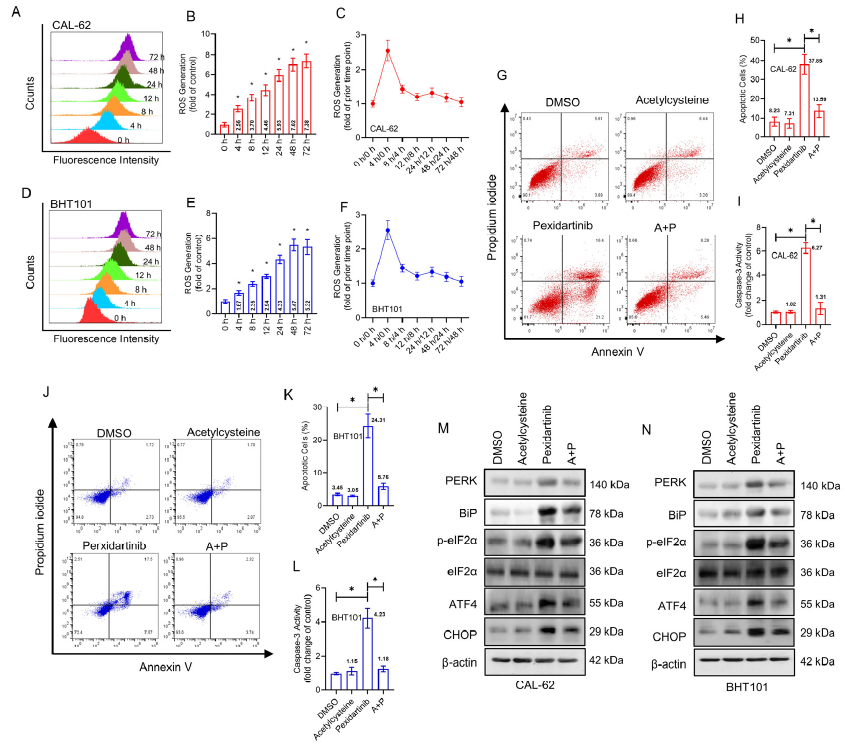
Figure 4. Pexidartinib induces ROS elevation in ATC cells. ( A , B ) ROS levels determined after treatment with pexidartinib at IC 50 concentration for various time points in CAL ‐ 62 cells. ( C ) Change in ROS generation was determined after treatment with pexidartinib at IC 50 concentration for various time points in CAL ‐ 62 cells. ( D , E ) ROS level was determined after treatment with pexidartinib at IC 50 concentration for various time points in BHT101 cells. ( F ) Change in ROS generation was determined after treatment with pexidartinib at IC 50 concentration for various time points in BHT101 cells. ( G – I ) Apoptotic cells detected in CAL ‐ 62 and cells after acetylcysteine or combination of acetylcysteine with pexidartinib. ( J – L ) Apoptotic cells were detected in CAL ‐ 62 and cells after acetylcysteine or combination of acetylcysteine with pexidartinib. ( M , N ) PERK ‐ dependent molecular pathways protein alteration on ER stress detected by Western blot after acetylcysteine or combination of acetylcysteine with pexidartinib. The original blots can be found in Figure S1. Data are presented as mean ± SD in at least three independent experiments (significance is presented as * when p < 0.05).